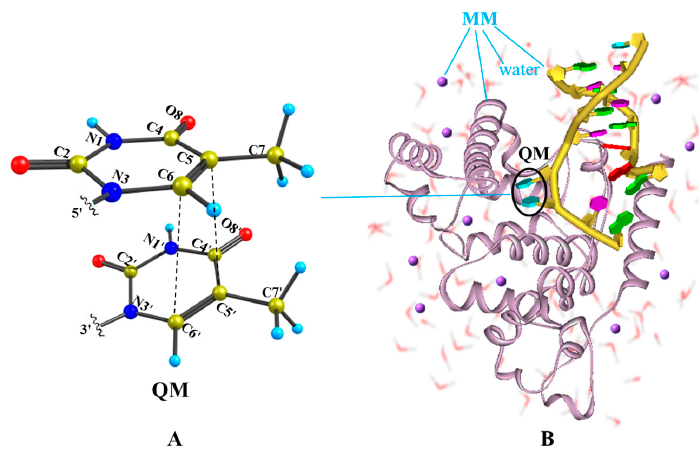
Figure 1. Illustration of the QM/MM computational protocol adopted in this work for finding the MEPs of thymine oligomer in DNA and solvent environment. ( A ) The QM subsystem includes two adjacent thymine bases; ( B ) The remaining of DNA bases, amino acid residues, crystal water molecules and counter-ion Na + are treated by the molecular mechanics.